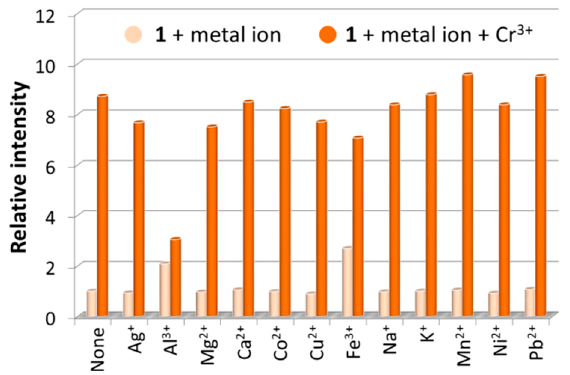
Figure 5. Fluorescence relative ratio responses of 1 in H 2 O suspensions containing various metal ions before and after addition of Cr 3+ ions with equal concentrations at 1.0 mM.